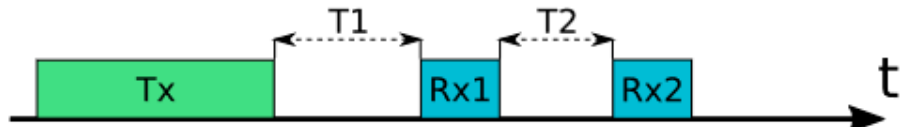
Figure 1. Transmission waveform for a Class A node (own source).